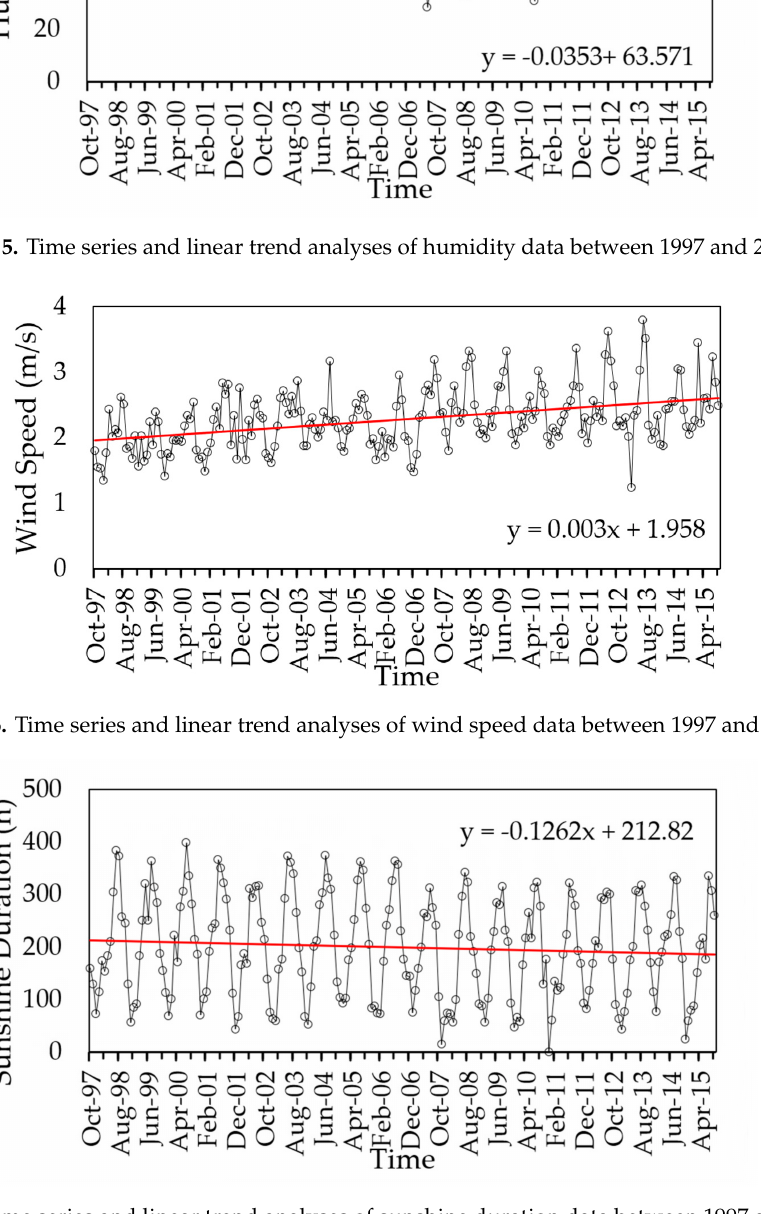
Figure 7. Time series and linear trend analyses of sunshine duration data between 1997 and